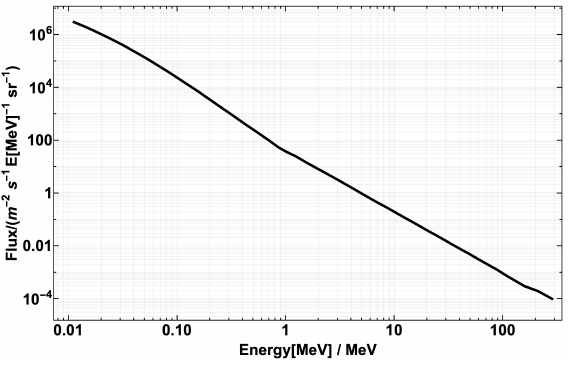
Figure 15. Extra-galactic photons flux as modeled by Integral [30] (up to 890 keV) and FERMI- LAT [31] at higher